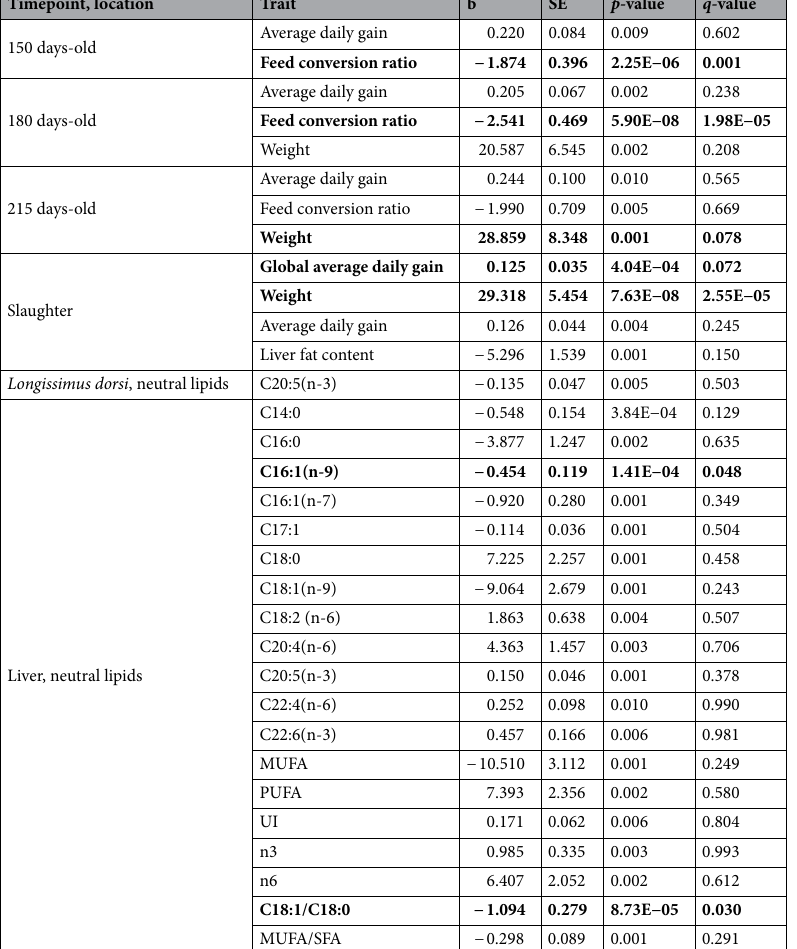
Table 2. Association results for polymorphisms in SCD gene (10_SCD, position 111,461,631). Traits with p‑ value < 0.01 are shown and those with q < 0.10 are highlighted in bold.